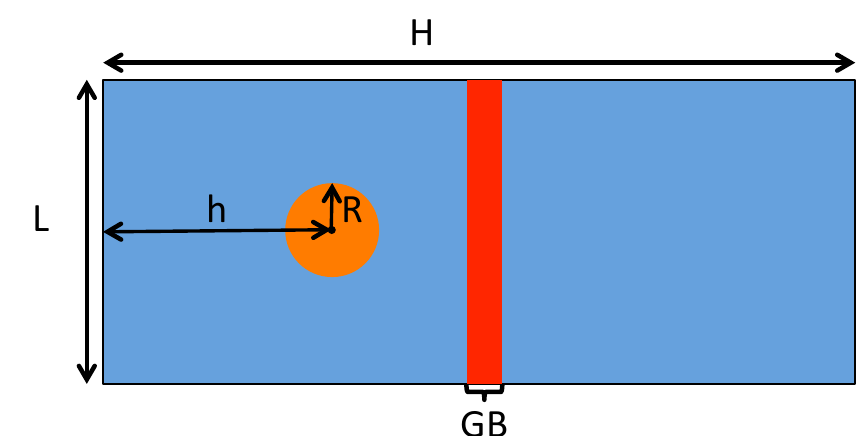
Figure 3. Spherical precipitate in the vicinity of a free surface or grain boundary. The Young’s modulus of the grain boundary is effectively either higher or lower than the value in the bulk. The sketch shows a two-dimensional cut through the three-dimensional system.